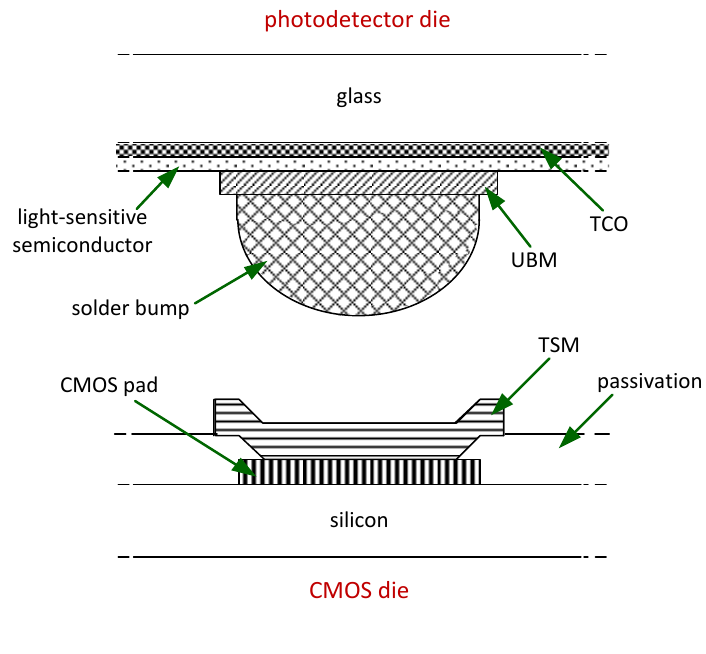
Figure 4. Pre-processing required for flip-chip bonding (not drawn to scale). TSM is deposited on the CMOS die, and UBM is deposited on the photodetector die. Solder bumps, tens of microns thick, are fabricated on the